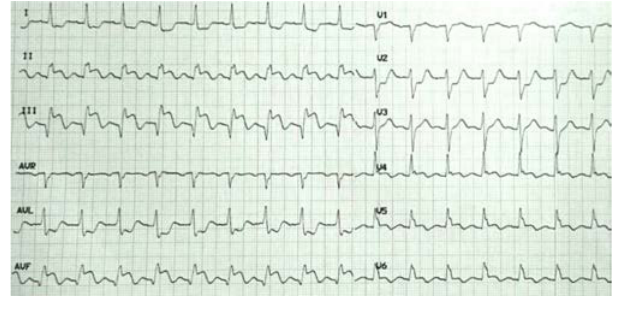
1. 12-lead-electrocardiogram showing ST-segment eleva- tions in the inferior leads (II, III, aVF), and ST-segment depres- sions in the anterolateral leads (I,